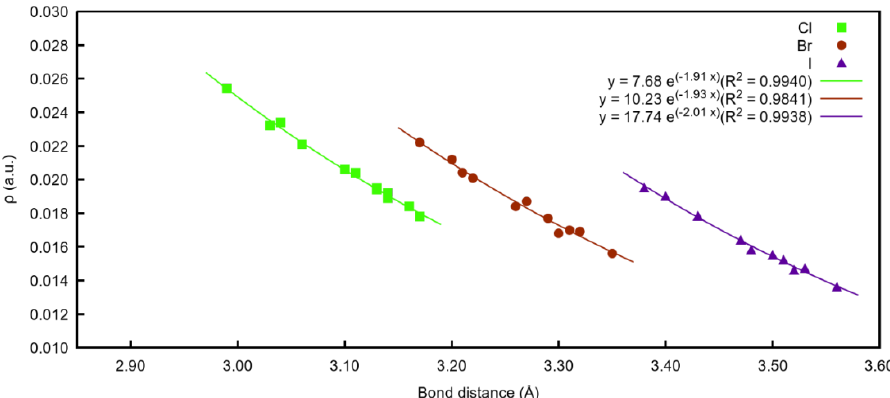
Figure 7. Exponential correlation density at BCPs vs. bond distances (X ··· I) regarding the three different halide atoms involved.